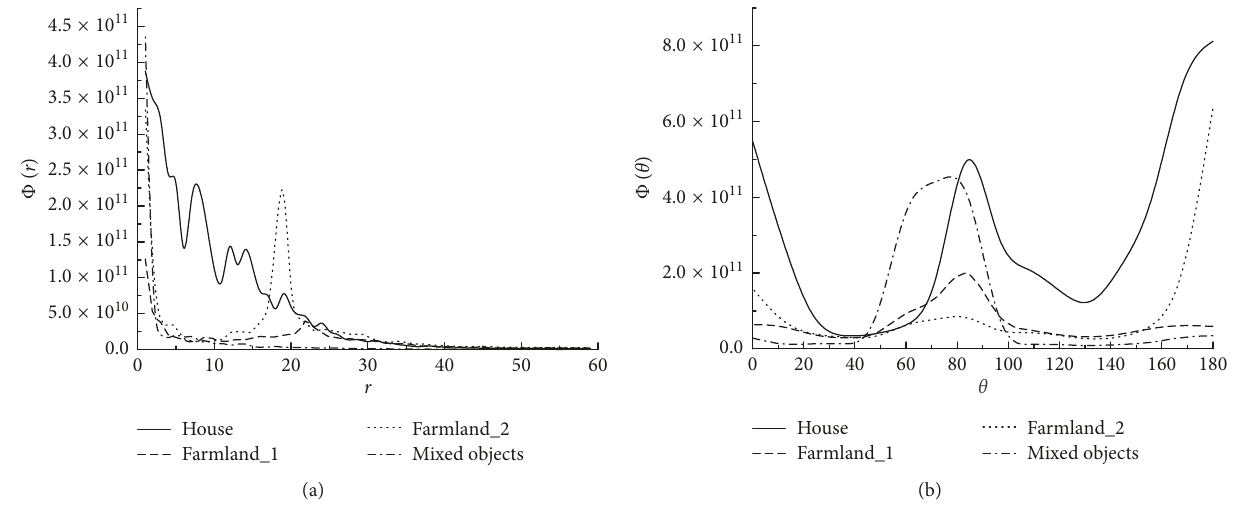
Figure 3: (a) Radial spectrum curve and (b) angular spectrum curve of four different subset